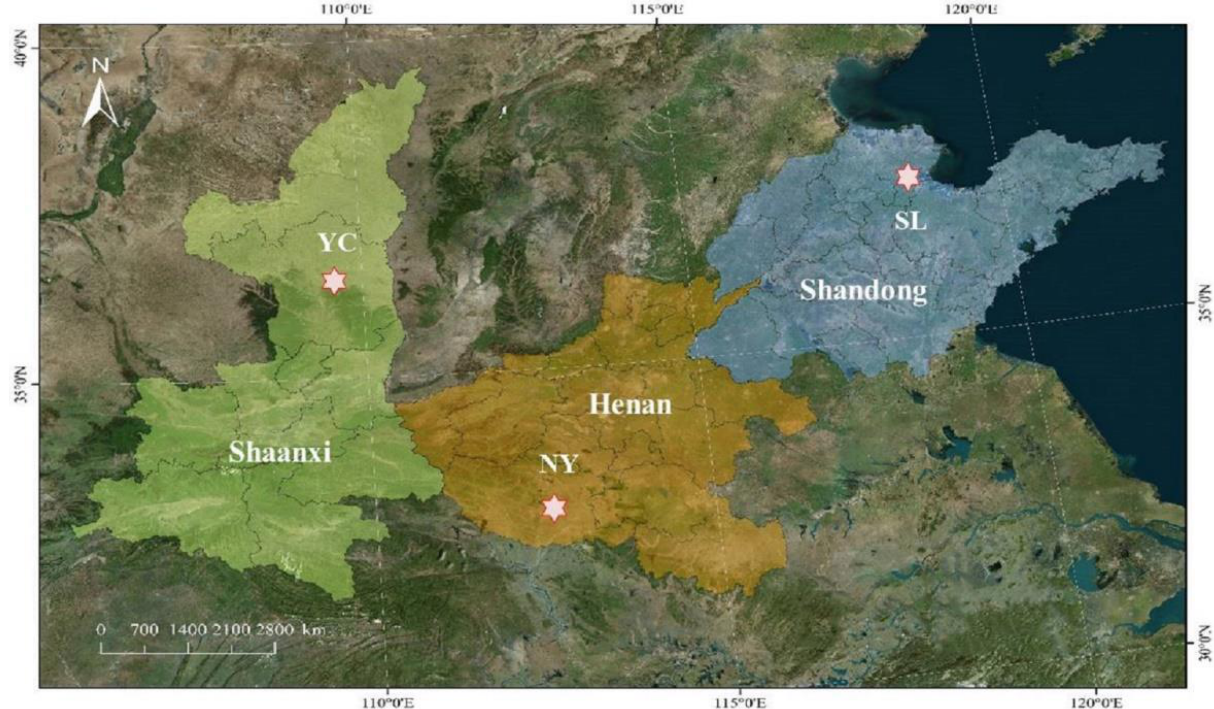
Figure 1. Geographical location of soil sampling in three typical oilfields.